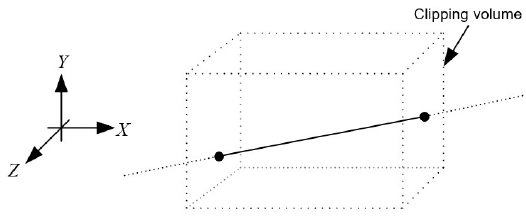
Figure 2. A line in the three-dimensional space after clipping.